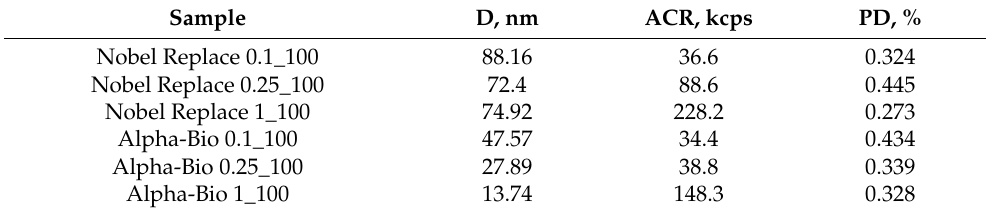
Table 5. Parameters of NSMP contained in supernatants obtained from the surfaces of Nobel Replace and Alpha-Bio dental implants.